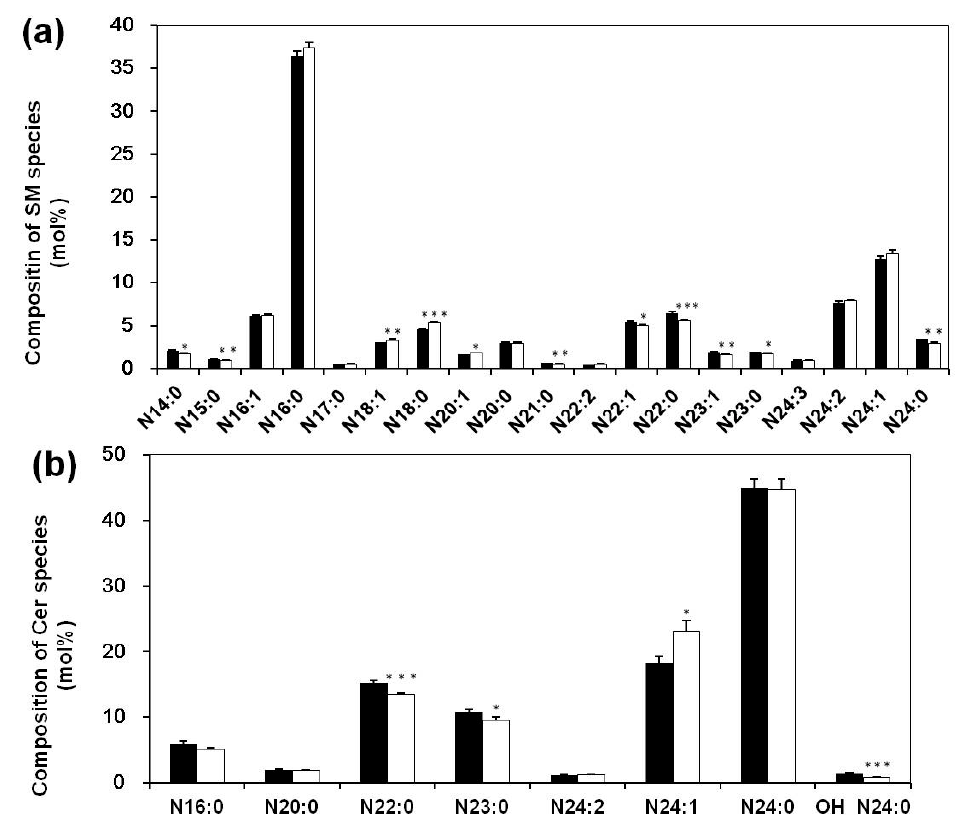
Figure 2. Comparison of the compositions of sphingomyelin (SM) and ceramide (Cer) species present in serum between SLE patients and healthy controls. The serum lipid extracts from SLE ( N = 30, open bar) and control ( N = 30, solid bar) groups were prepared by using a modified Bligh and Dyer extraction protocol as described in Section 2. The data represented mean ± SEM ( N = 30 per group) from different peoples. * p < 0.05, ** p < 0.01, *** p < 0.001 compared with controls. “N” represents the amide linage of the acyl chain.